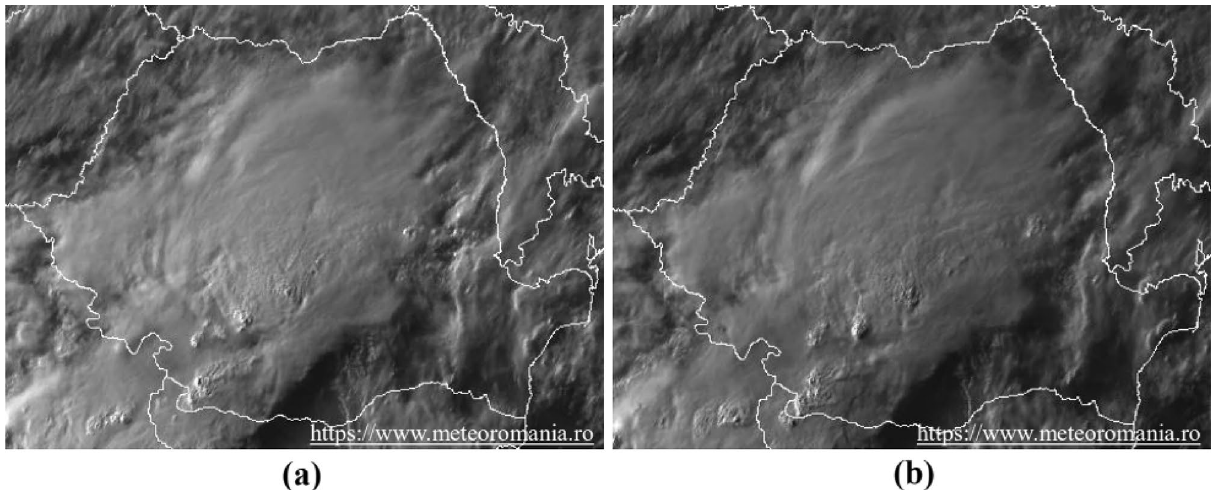
Figure 14. Image showing clouds, acquired on May 20, 2020, ( a ) at 4:15 p.m. and ( b ) at 4:30 p.m. Source: https:// www. meteo roman ia. ro.